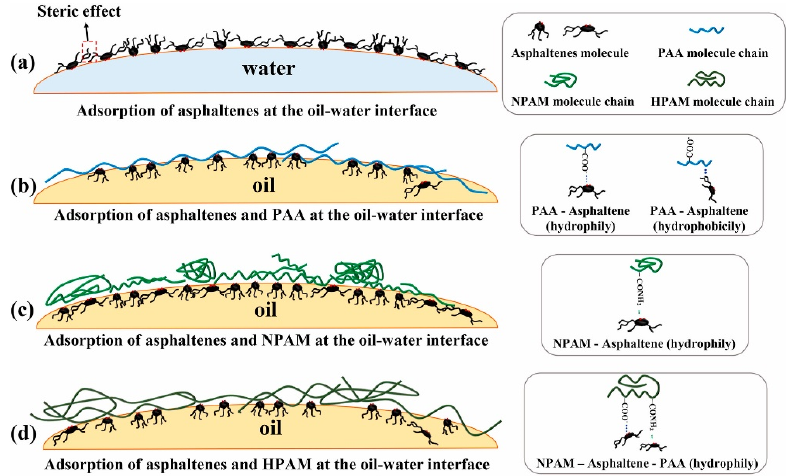
Figure 20. Schematic diagram of interaction on the oil–water interface. Formation of asphaltenes interfacial films ( a ). Interfacial films of synergistic interaction between PAA and asphaltenes ( b ). Interfacial films of synergistic interaction between NPAM and asphaltenes ( c ). Interfacial films of synergistic interaction between HPAM and asphaltenes ( d ). Reprinted with permission from Ref.